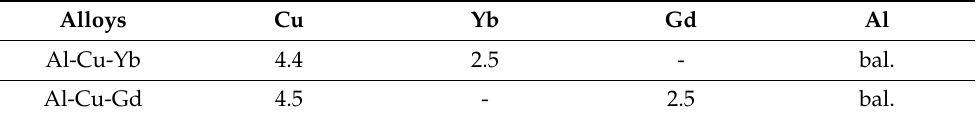
Table 1. Chemical composition of the alloys, wt %. Alloys Cu Yb Gd Al Al-Cu-Yb 4.4 2.5 - Al-Cu-Gd 4.5 -